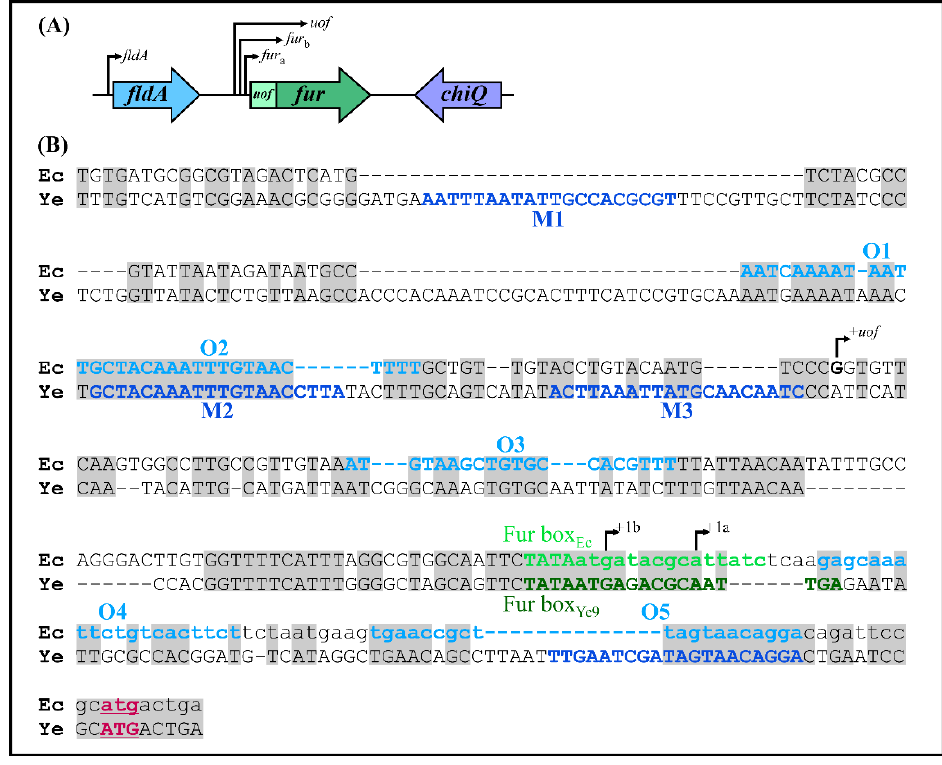
Figure 8. Comparison of the fur loci of Y. enterocolitica and E. coli . ( A ) Chromosomal organization of the E. coli fur locus. The direction of transcription from the fldA , uof and the two fur promoters is indicated by arrows (based on 47 and 85). The following products are encoded by these genes: fldA —flavodoxin I, uof —Fur leader peptide , fur —Fur (ferric uptake regulator), chiQ —chitosugar-induced lipoprotein. ( B ) Alignment of the fur regulatory regions of E. coli and Y. enterocolitica . Chromosomal sequences of E. coli (Ec) and Y. enterocolitica (Ye) extending from the end of the fldA gene to the start codon of fur (plus five nucleotides from the end of the uof gene present in E. coli ) were aligned using BlastN. Identical nucleotides are shaded gray. The putative transcription start sites of E. coli fur (a and b) and uof are indicated by +la, + lb and +1 uof , respectively. Putative OmpR-binding sites (M1–M4) from Y. enterocolitica are in dark blue text, while putative E . coli OmpR-binding sites (O1–O5) are in light blue. The Fur-binding sites (Fur boxEc and Fur boxYe9 ) are in light and dark green text, respectively. The sequence of E. coli uof is written in lowercase text. The fur translation start codons are in bold, underlined and colored pink.